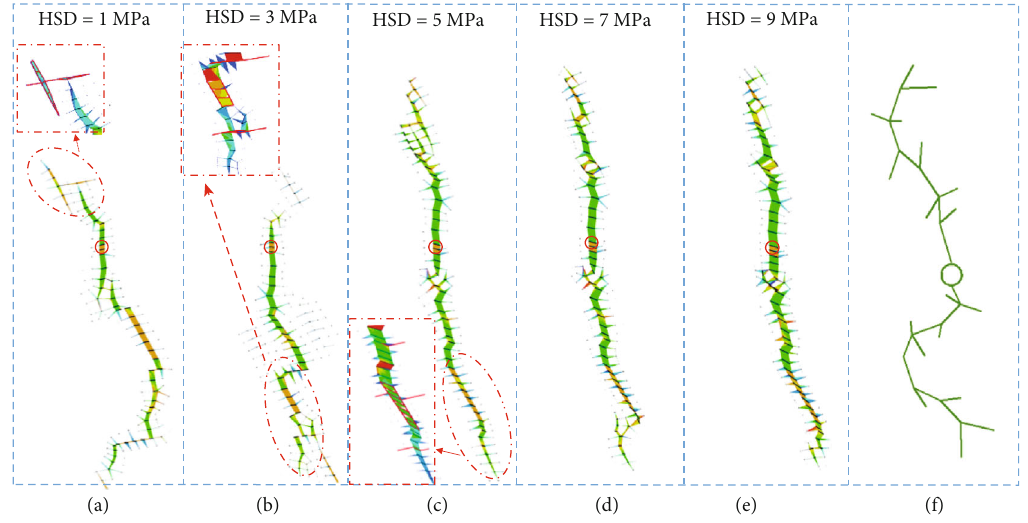
Figure 9: Hydraulic fracture morphology with di ff erent stress di ff